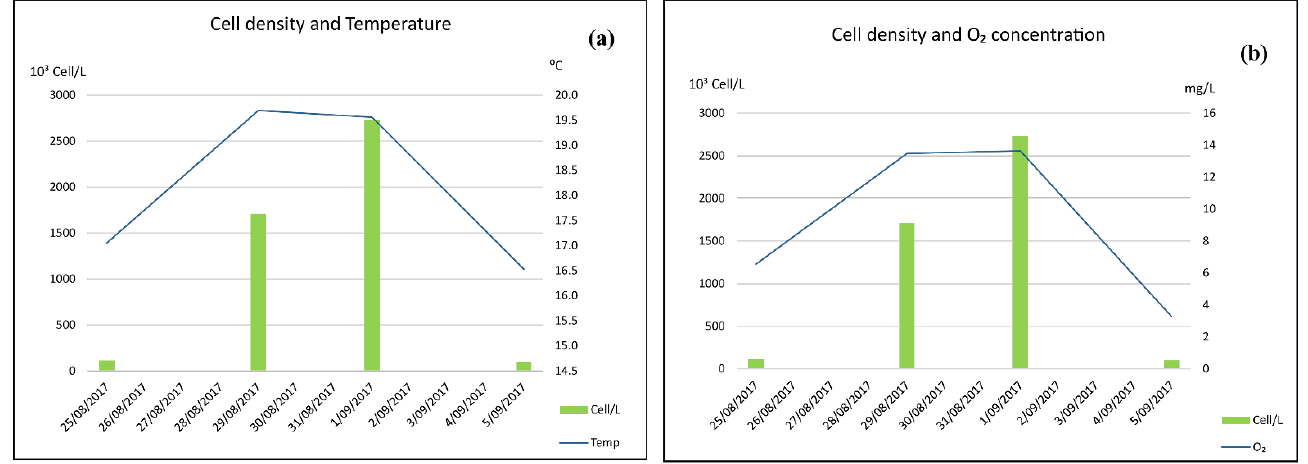
Figure 2. ( a ) Cell density and temperature and ( b ) cell density and dissolved oxygen from Paracas Bay.